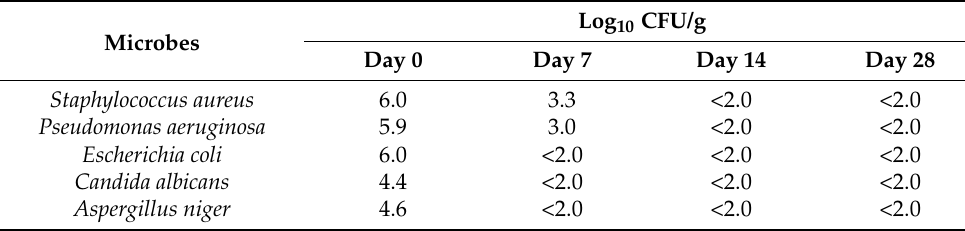
Table 10. Preservation efficacy of the anti-cellulite